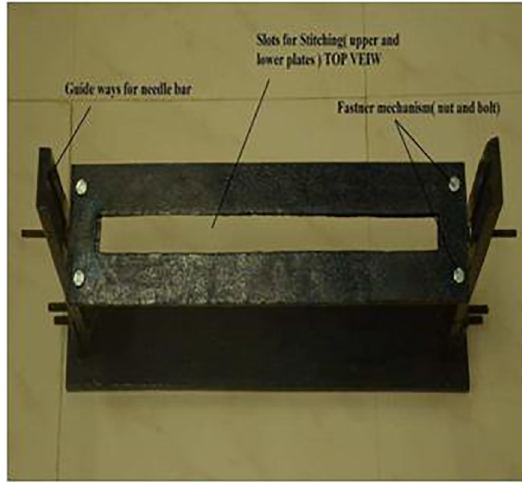
Figure 5. Top View of the Stitching Machine.